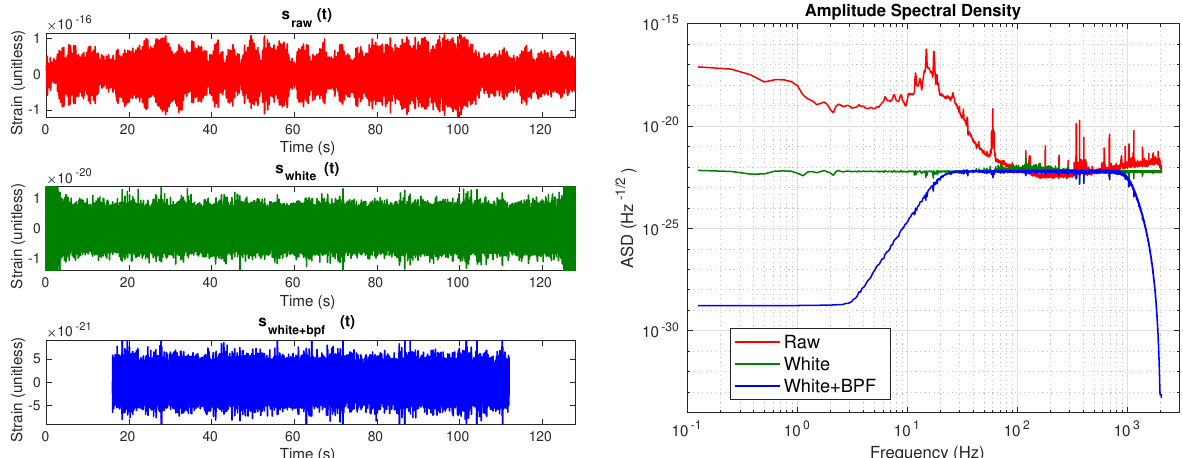
Figure 2. Illustration of the raw strain data cleaning. The left panel shows three plots as time series segments. First, a segment of raw strain data of 128 s after we applied the blackman window. Second, the resulting strain data after the whitening, in which it is noticeable the spurious effects at the edges. Finally, the cleaned segment of data after applied the band-pass filtering and edges removal to the previous whitened segment of data. In the right panel, we plot the same data, but now in the amplitude spectral density (ASD) vs. frequency